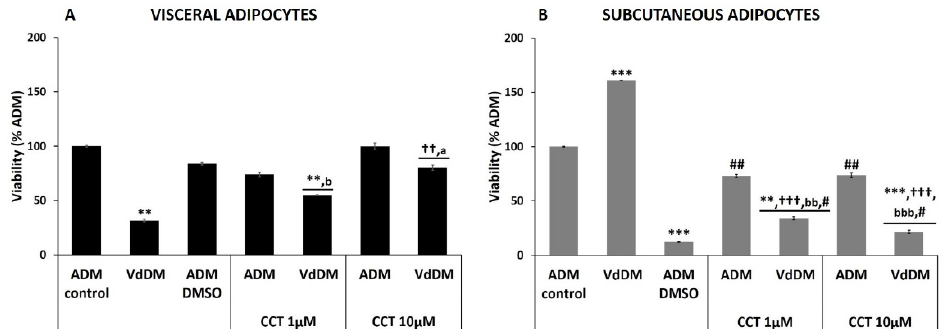
Figure 4. Effect of VdDM secretome and CCT on viability of adipocytes. The maximum cell viability detected for control differentiation (ADM-control) was set at 100%. Relative values of adipocyte viability in different conditions are shown: VdDM-differentiated cells, ADM–DMSO, and CCT applied to ADM- and VdDM-differentiated cells. Values were obtained at 17 days post-induction. Panel ( A ): percentage of cellular viability of visceral adipocytes. Panel ( B ): percentage of cellular viability of subcutaneous adipocytes. Bars indicate mean ± SEM of absorbance ( λ 595 nm) from at least three replicates of each condition. Significant differences are represented as: ** *** compared to ADM-control, p < 0.01 and p < 0 .001, respectively. ††, ††† compared to VdDM p < 0.01 and p < 0.001, respectively. #, ## compared to ADM–DMSO, p < 0.05 and p < 0.01, respectively. “a” comparisons between CCT dose, p < 0.05. “b, bb, bbb” comparison between VdDM–CCT and